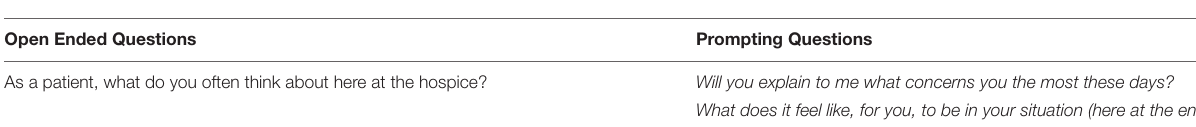
TABLE 1 | Examples from the interview